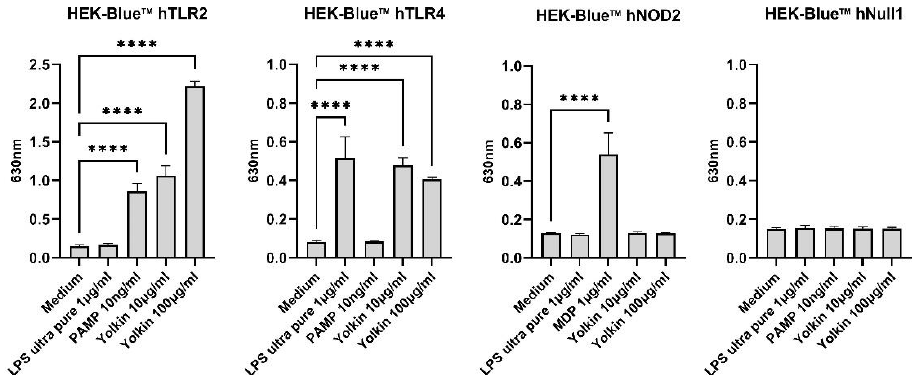
Figure 8. Recognition of yolkin samples by innate immune receptors. HEK Blue TM cells were seeded on the plate and stimulated with yolkin samples in 3 repetitions and at concentrations of 10 µ g/mL and 100 µ g/mL according to the manufacturer’s instruction. To analyze yolkin recognition over time, a set of absorbance measurements was performed at 610, 630 and 650 nm. Then, 630 nm was selected as the representative. LPS was used as a positive control for TLR4 cells and negative for TLR2 and NOD2 cell lines. A positive control for TLR2 recognition was PAMP and for the NOD2 receptor it was MDP. All of the obtained results were statistically significant. A one-way ANOVA with Dunnett’s multiple comparison test was used to compare treated cells with non-treated control (medium). **** p ≤ 0.0001.